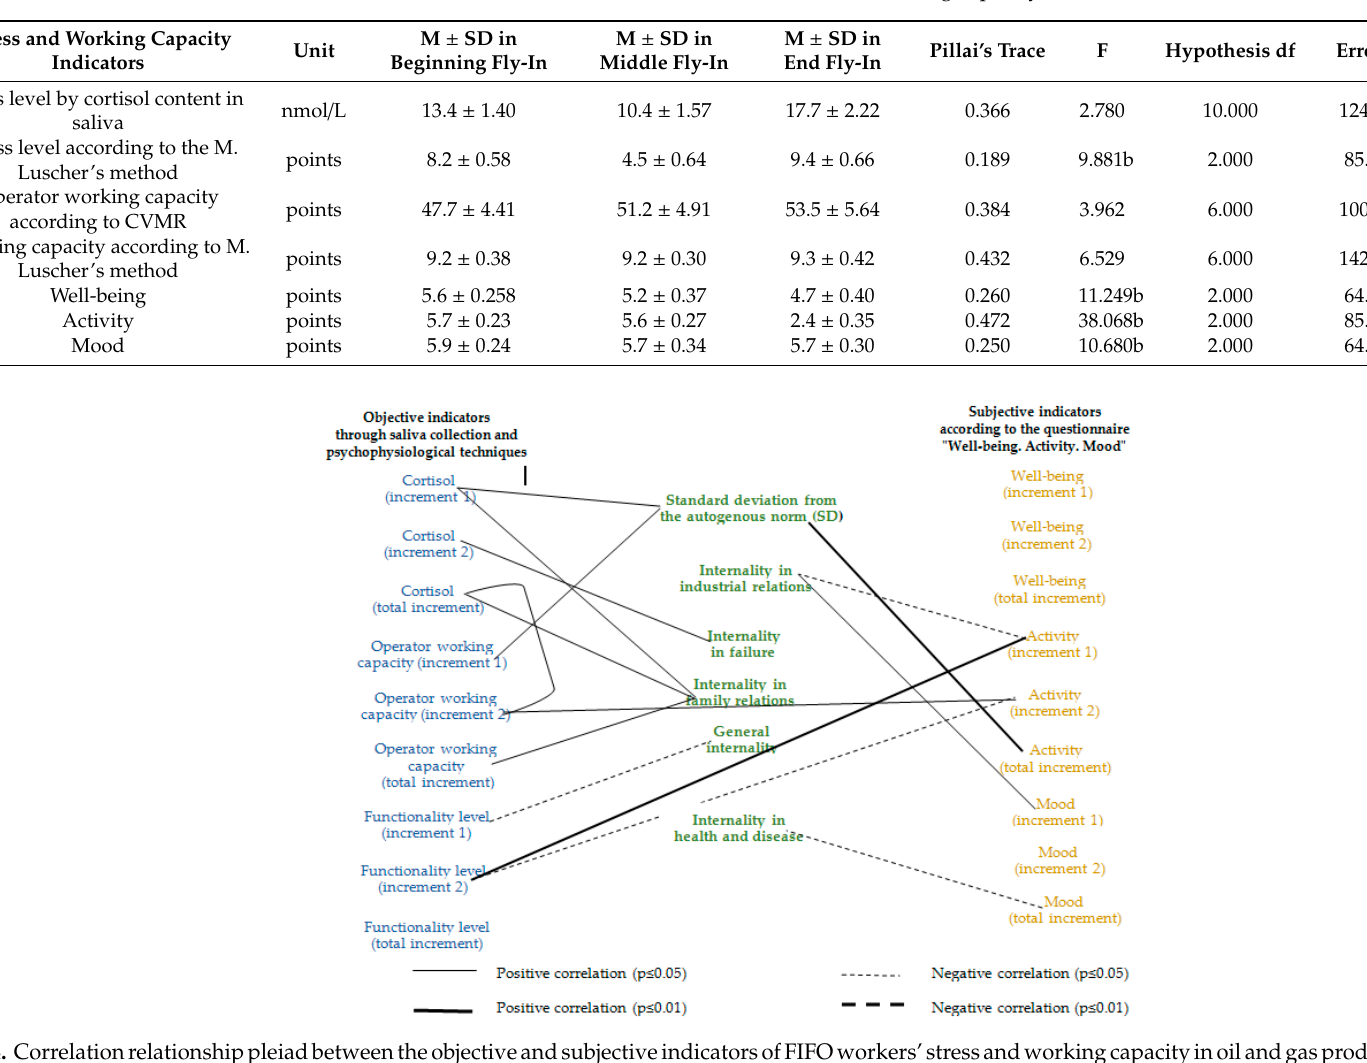
Table 2. The ANOVA results in relation to the stress and working capacity indicators.